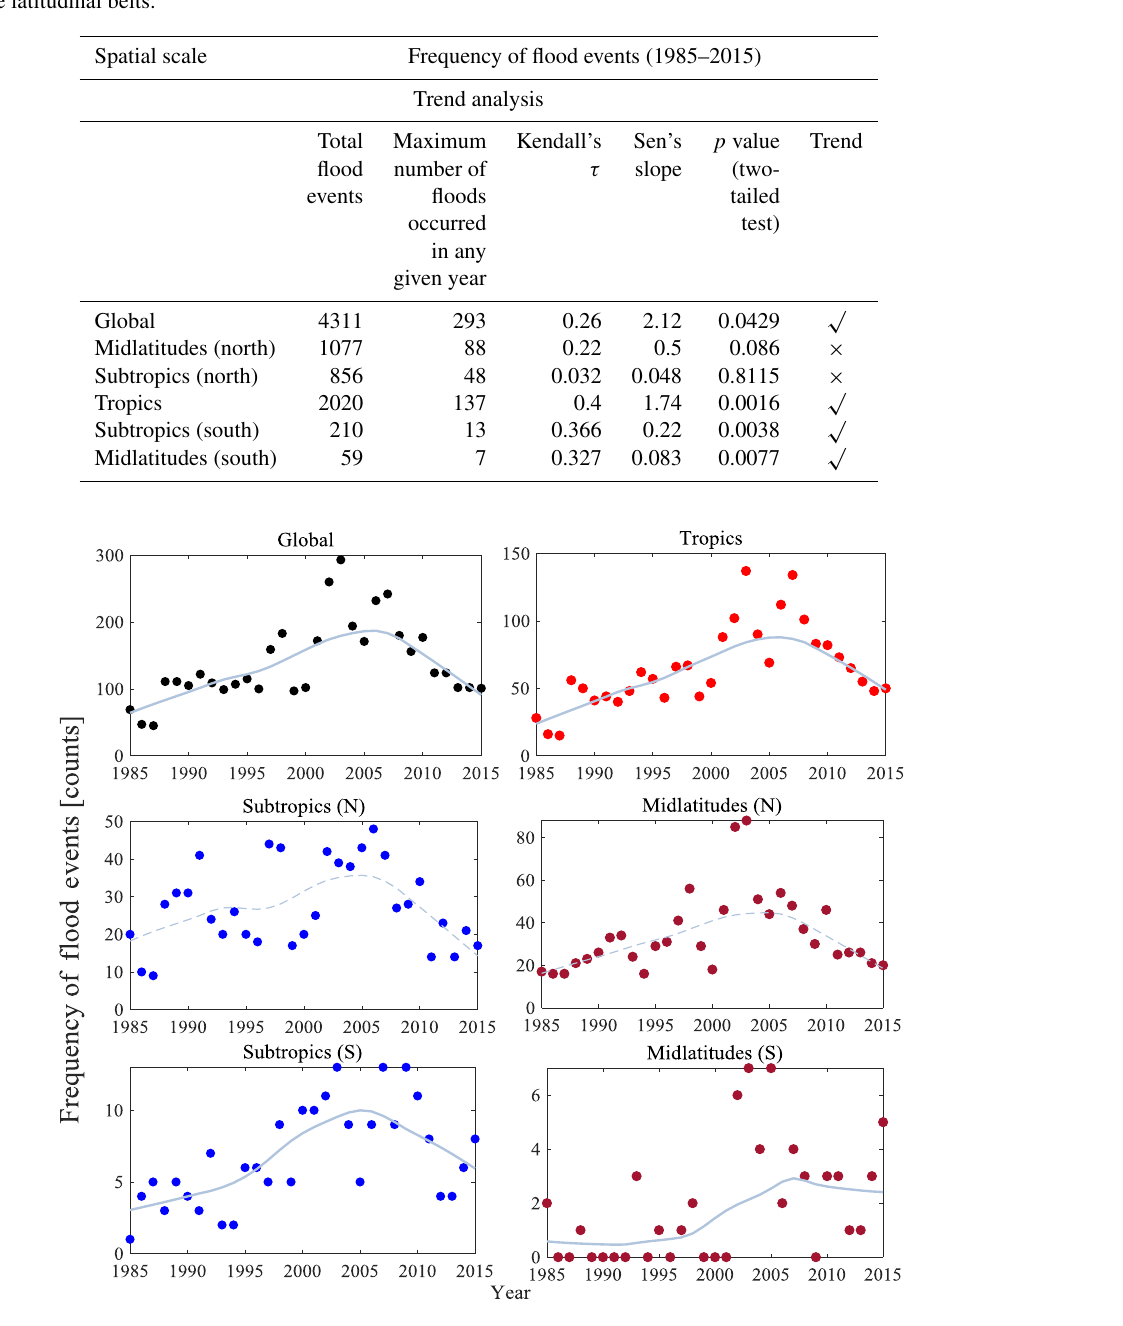
Figure 2. Frequency of flood events at the global scale and the latitudinal scales (i.e., tropics, subtropics – N, subtropics – S, midlatitudes – N, and midlatitudes – S); a LOESS curve fitting is shown (solid line) for the time series in which a significant trend in the number of flood events is observed (Mann–Kendall test with significance level α = 0.05). A dashed line indicates the LOESS curve for the regions with insignificant